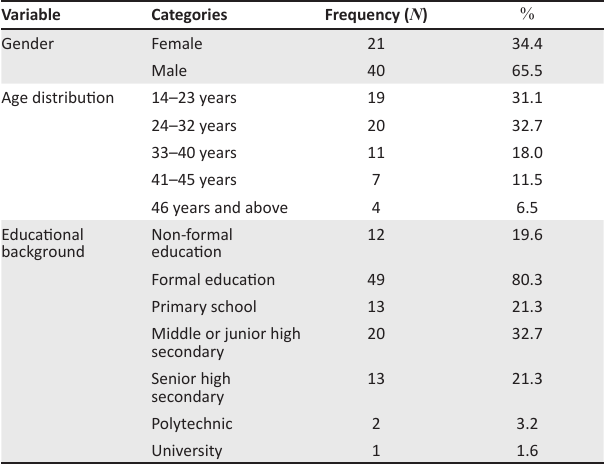
TABLE 1: Profile of the